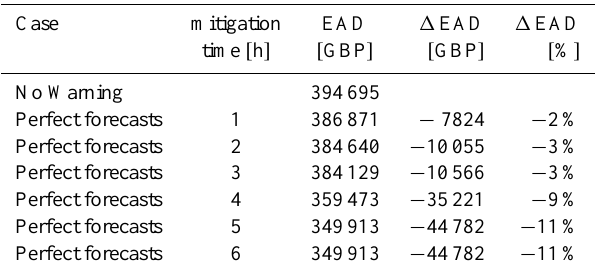
plotted as a function of r (Fig. 5). This shows that for users whose costs are negligible (which means that r ≈ 0), the maximum loss reduction is attained (i.e. that of the Perfect Forecasts case), with an increase of losses avoided as lead- time increases (Eq. 2). Flood risk increases with cost-loss ratio; if the cost of warning response approaches the amount of potential loss reduction ( r → 1), flood risk